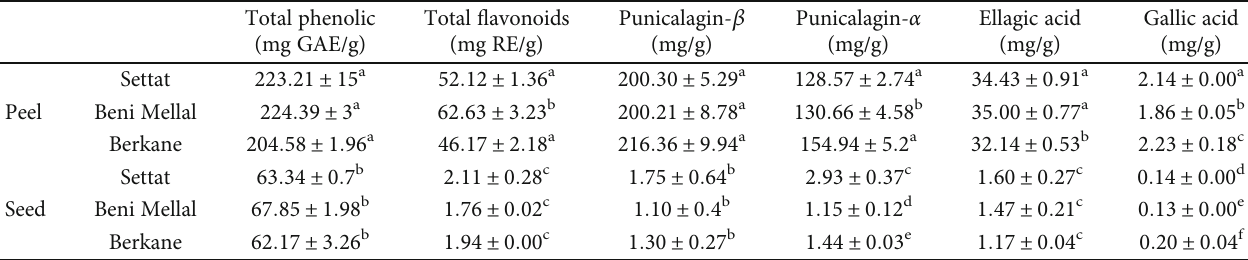
Table 1: Qualitative – quantitative analyses of the polyphenolic fraction in selected